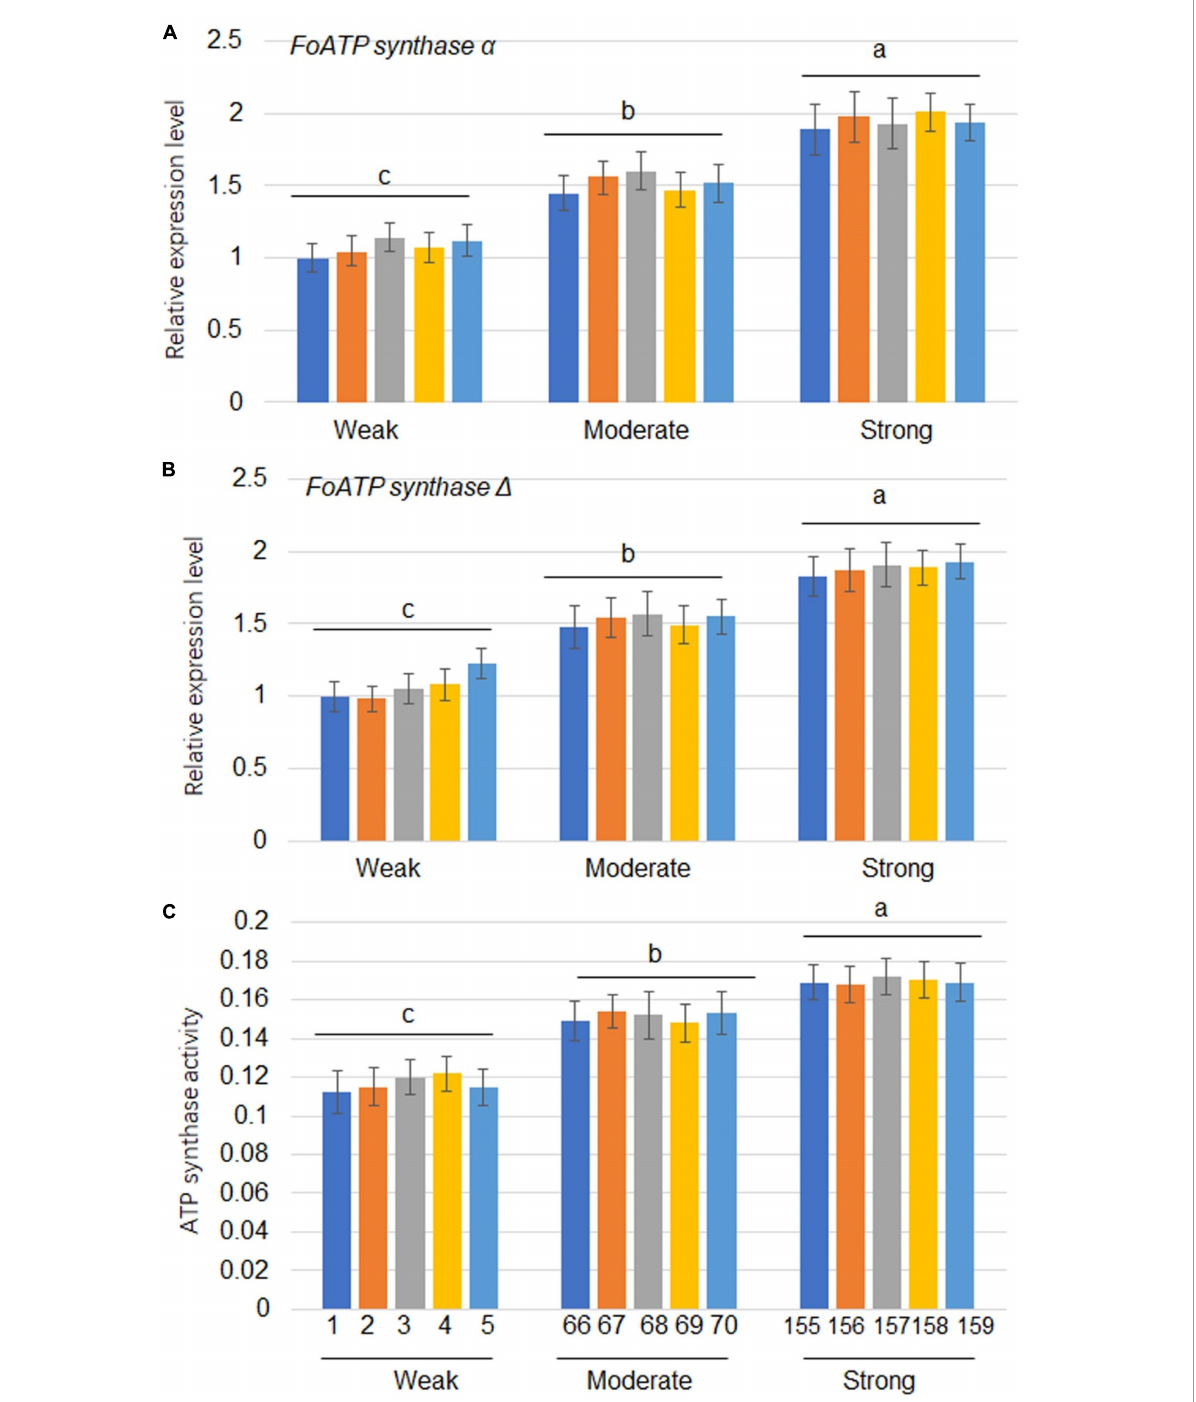
FIGURE4 The expression levels of ATP synthase α and ATP synthase (cid:49) as well as ATP synthase activity in Fusarium oxysporum strains with different levels of virulence. The expression levels of FoATP synthase α (A) and FoATP synthase (cid:49) (B) in F. oxysporum strains displaying three different levels of virulence (weak, moderate, or strong; 5 strains for each type of virulence). (C) ATP synthase activity was measured in F. oxysporum strains displaying three different levels of virulence. The line numbers of each virulence type were the same as shown in Figure 1 . Different letters above the bars indicate significant differences ( P <